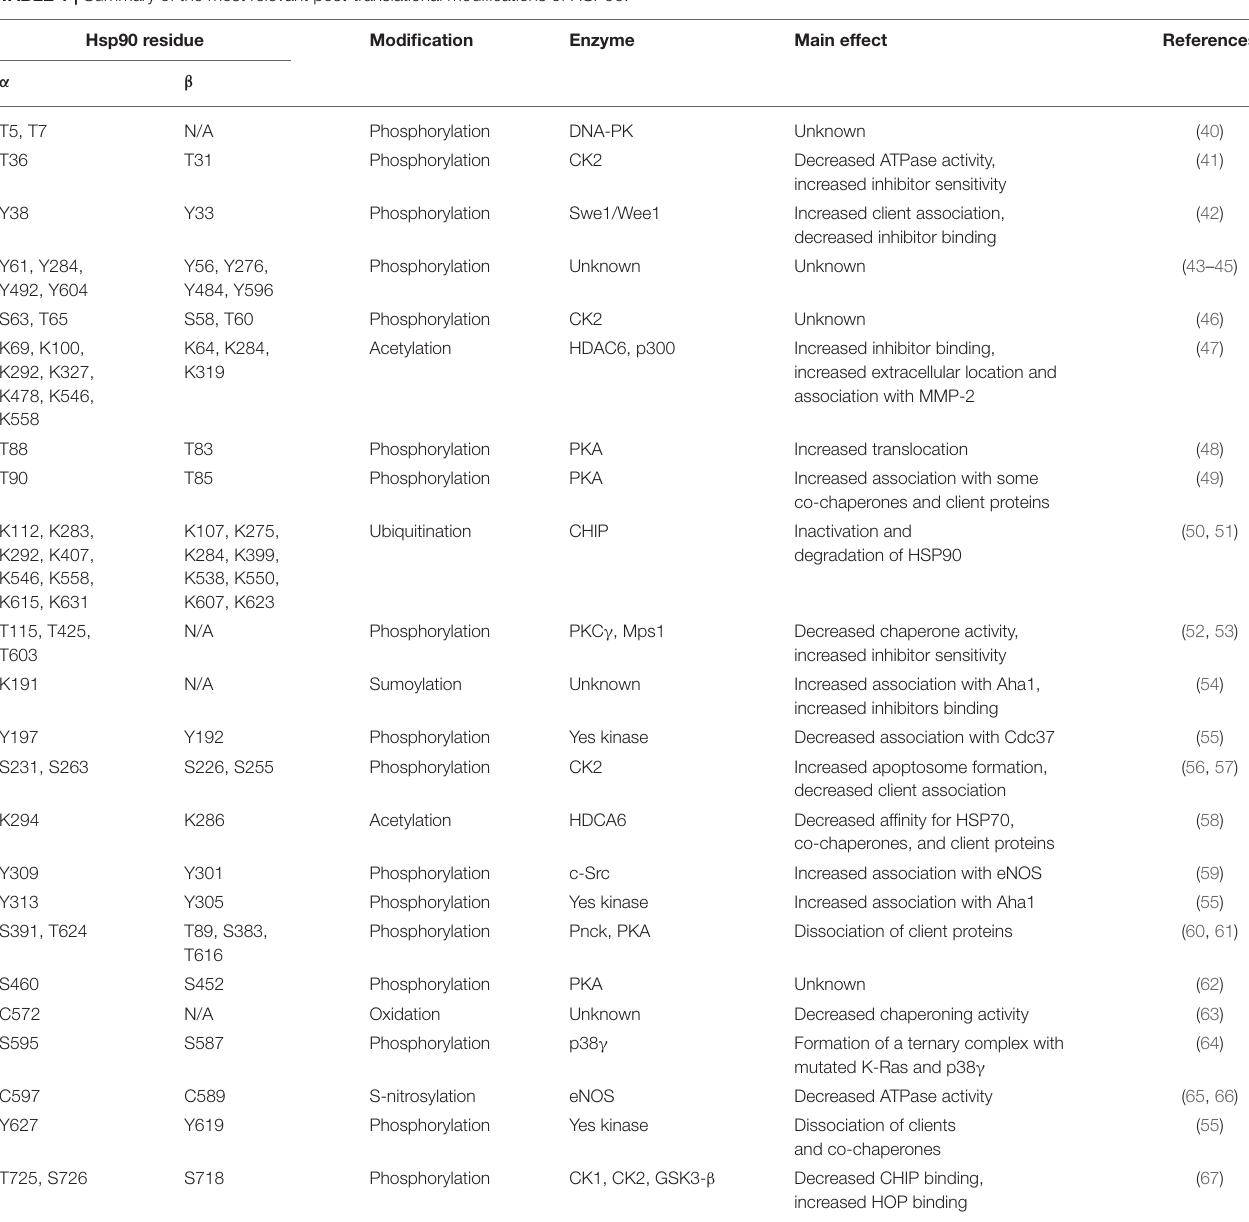
TABLE 1 | Summary of the most relevant post-translational modifications of